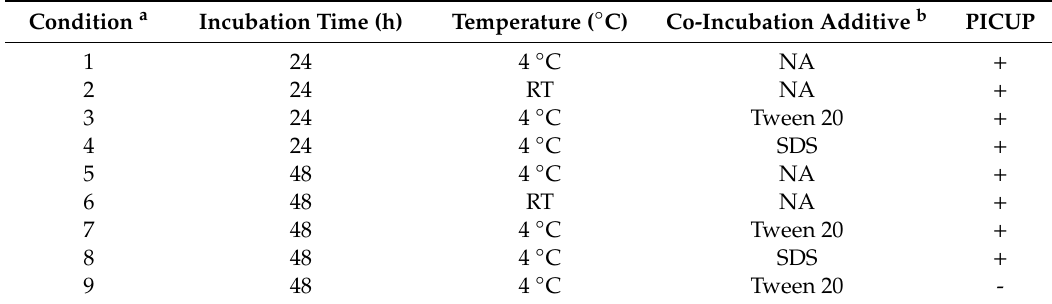
Table 1. A β (M1–40) oligomer incubation conditions.